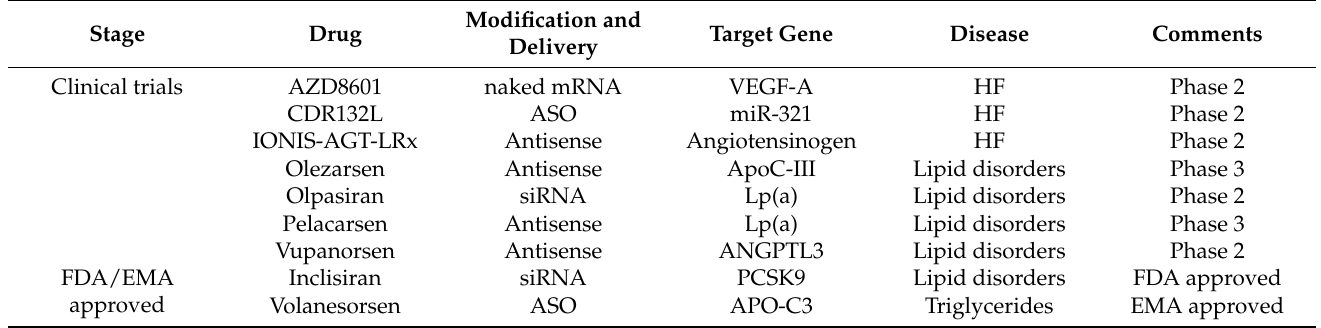
Table 3. RNA Therapies Approved or in Clinical Trials for